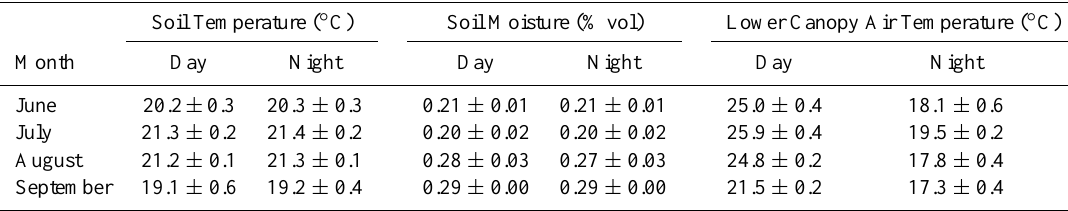
Table 3. Soil temperature at 10cm ( ◦ C), volumetric soil water content at 10cm and lower canopy air temperature ( ◦ C) in the treatment plots at FACTS-1. Reported values are means and standard error ( n = 3) of the days experiments were